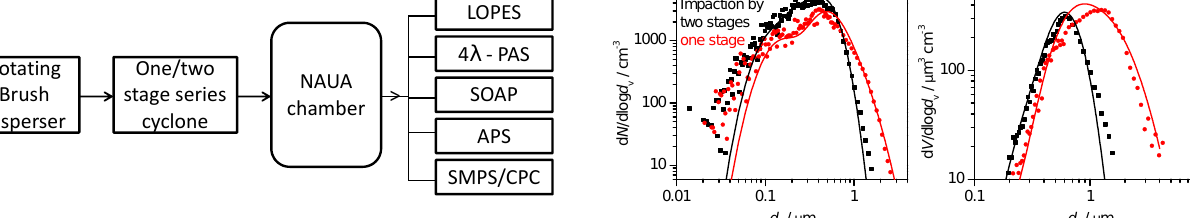
Fig. 1. Schematic set-up of the NAUA chamber experiments with dispersed Saharan soil samples, including aerosol generation and characterisation by LOPES (Long-path Extinction Spectrome- ter), 4 λ -PAS (four wavelength photo acoustic spectrometer), SOAP (Spectral Optical Absorption Photometer), APS (Aerodynamic Par- ticle Sizer), and SMPS/CPC (Scanning Mobility Particle Sizer, Condensation Particle Counter).